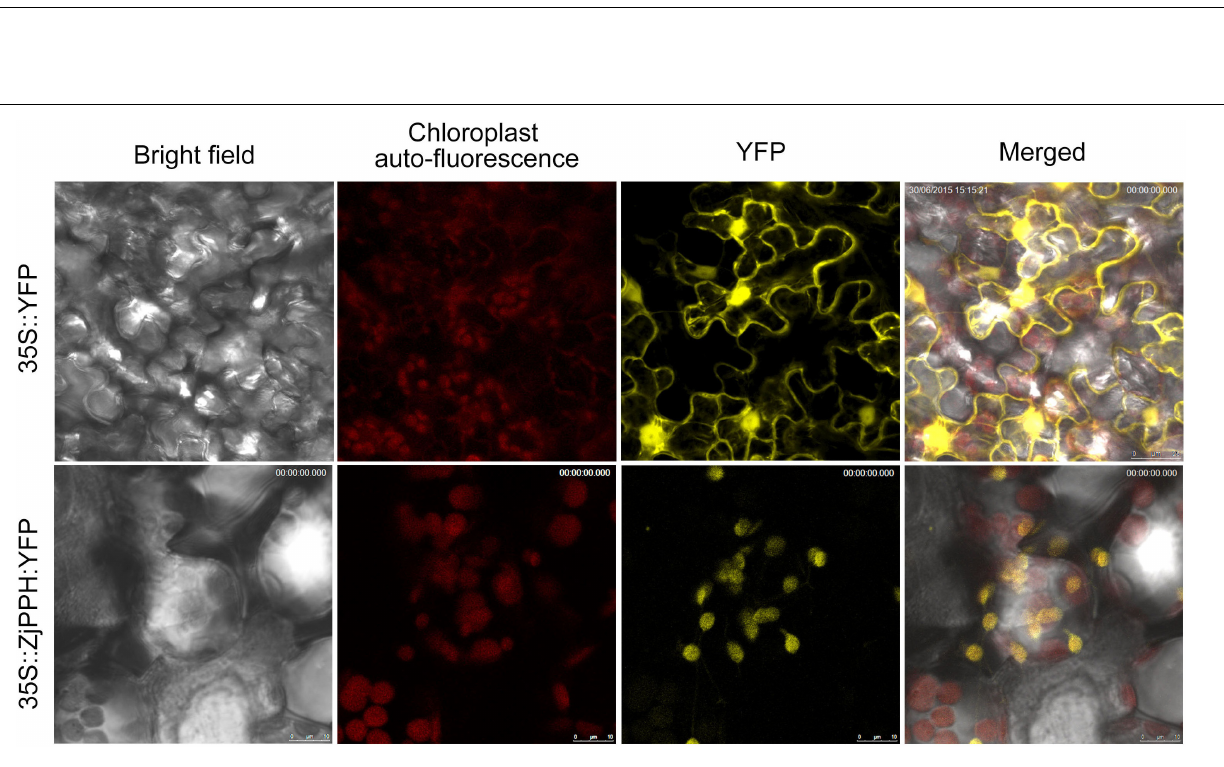
FIGURE 3 | Transcriptional expression characters of ZjPPH. (A) Different organs. (B) Leaves at different growth stages. Continuous expression tendency under different treatments: ABA (C) , MeJA (D) , SA (E) , and dark (F) . Data were expressed as mean ± SD ( n = 4). Different letters indicate significant differences at p ≤ 0.05 based on Fisher’s protected least significant difference (LSD) test.